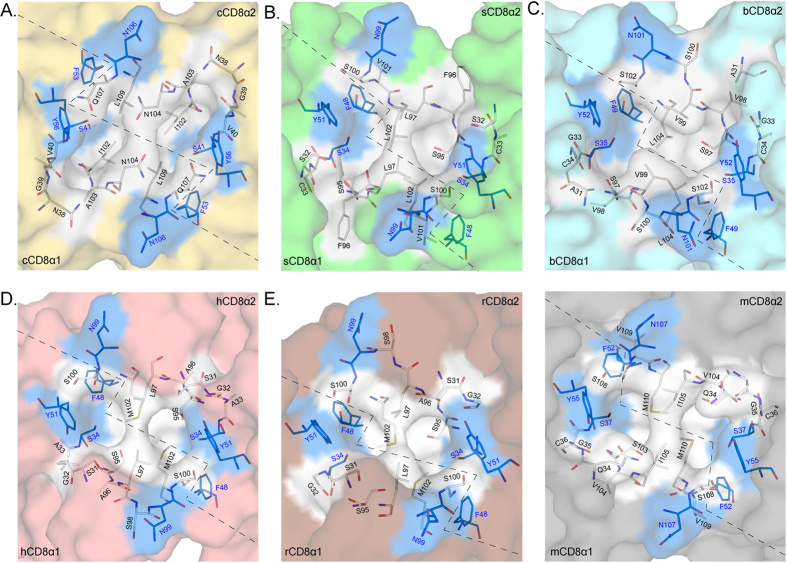
Compositions of binding cavities in the six known CD8αα structures.The cavities and residues of cCD8αα, sCD8αα, bCD8αα, hCD8αα, rCD8αα and mCD8αα homodimers are shown in (A–F) The conserved residues are coloured blue, and non-conserved residues are white. The two different monomers are separated by dashed line.